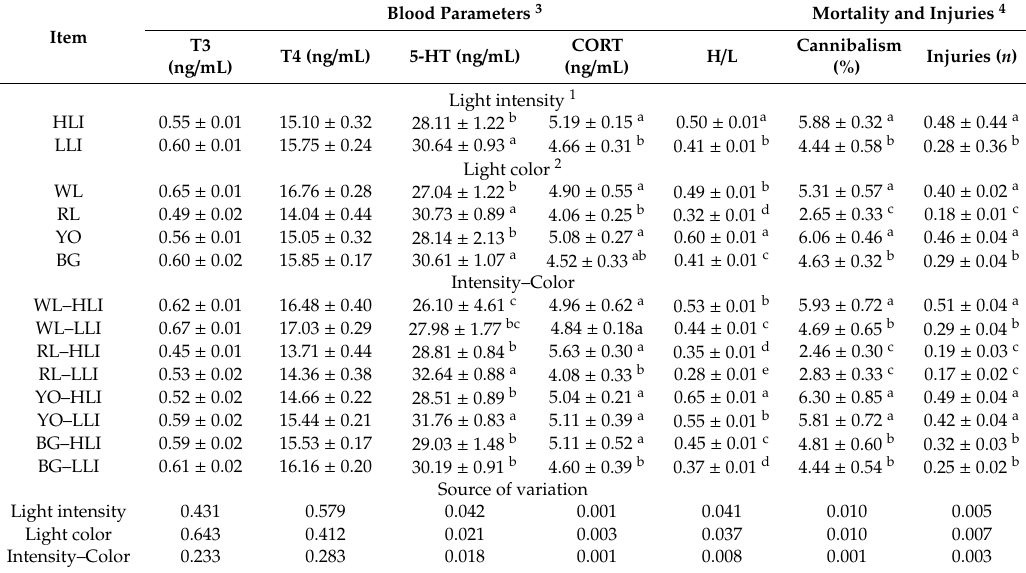
Table 6. Means ( ± SE) of blood parameters, mortality and cannibalistic injuries of hens in response to light colors and light intensities